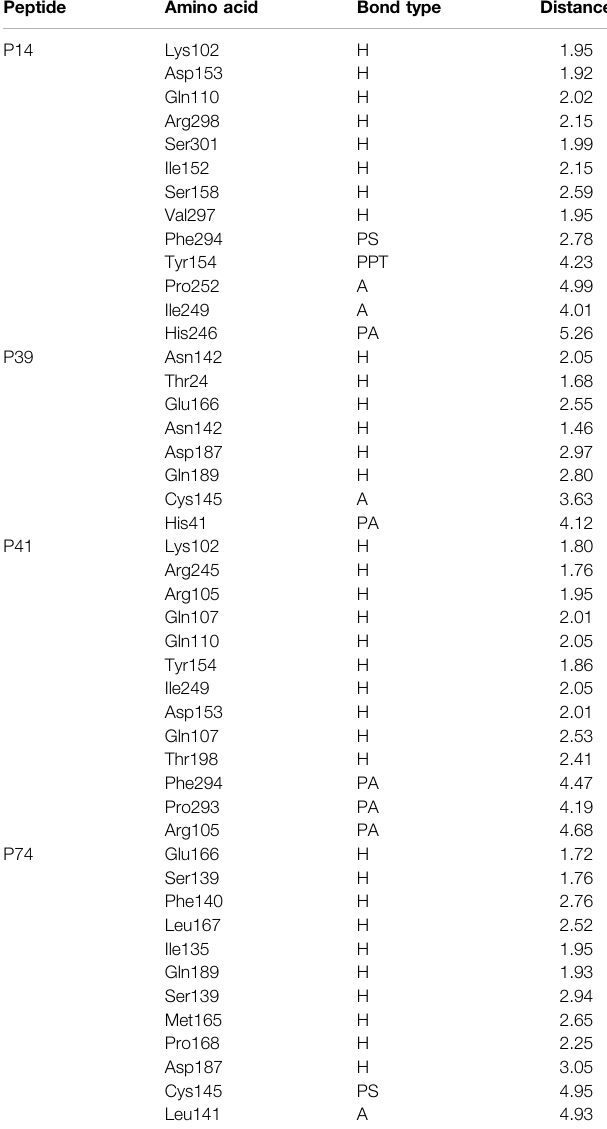
TABLE 2 | Nonbonded interaction of the top four peptides and main protease of the SARS-CoV-2, here, H, A, PA, PS, and PPT denote hydrogen bond, alkyl bond, Pi-alkylbond, Pi-sulfur bond, and Pi – PiT-shaped interactions,respectively. Peptide Amino